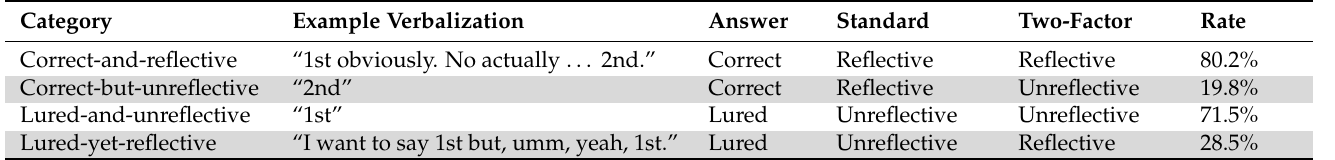
Table 1. Standard and two-factor categorizations of reflection test responses based on think-aloud protocol analysis of responses to the verbal reflection test in Study 1. Example verbalization based on the following reflection test question: “If you were running a race, and you passed the person in 2nd place, what place would you be in now?”.